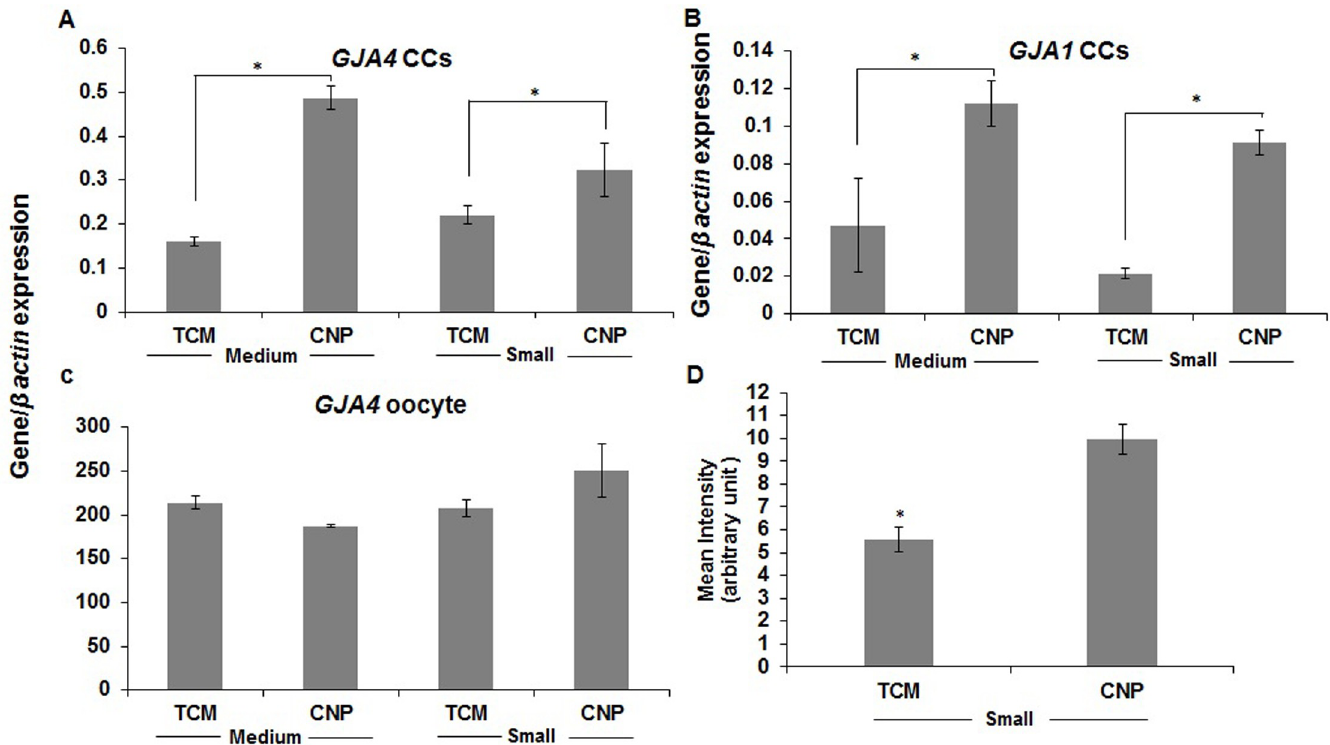
Fig 6. A , B , C : Gene expression of GJA4 and GJA1 between TCM and CNP groups in medium ( > 4 to 6 mm) and small (2 to � 4 mm) size follicles. 3 replicates and the minimum number of oocytes and cumulus cells in each replicate were 30 and 2 × 10 5 cells, respectively. D : Calcein uptake through gap junctions between TCM and CNP groups in COCs derived from small size follicles (2 to � 4 mm). 3 replicates and the minimum number of oocytes in each replicate were 10. The asterisks represent a significant difference. GJA: gap junction protein alpha, TCM: tissue culture medium, CNP: natriuretic peptide type C.